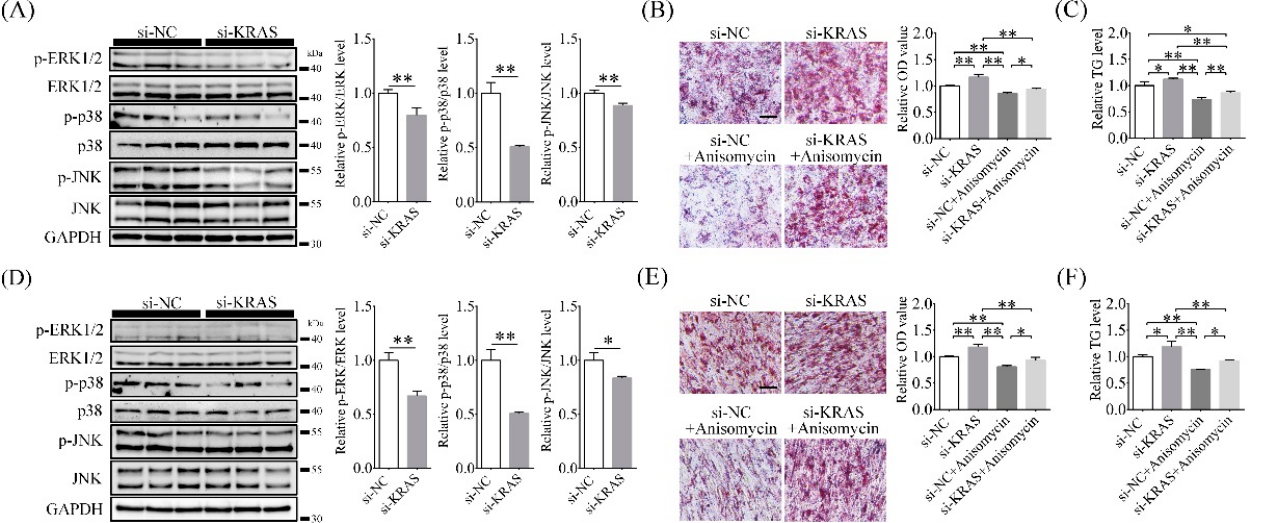
Figure 6. Effects of KRAS on mitogen-activated protein kinases (MAPK) activation in 3T3-L1 and C2C12 cells. ( A ) Changes in extracellular regulated protein kinases (ERK), c-Jun N-terminal kinase (JNK), and p38 phosphorylation levels in 3T3-L1 cells detected by Western blot analysis. Significant differences are represented with ** ( p < 0.01). ( B ) The representative ORO staining images and relative ORO OD values showed the different lipid accumulations in 3T3-L1 cells with different treatments after induction of adipogenic differentiation. Scale bar = 50 µ m. Significant differences are represented with * ( p < 0.05) and ** ( p < 0.01). ( C ) The relative TG level changes in 3T3-L1 cells with different treatments. Significant differences are represented with * ( p < 0.05) and ** ( p < 0.01). ( D ) Changes in ERK, JNK, and p38 phosphorylation levels in C2C12 cells detected by Western blot analysis. Significant differences are represented with * ( p < 0.05) and ** ( p < 0.01). ( E ) The representative ORO staining images and relative ORO OD values showed the different lipid accumulations in C2C12 cells with different treatments after induction of adipogenic differentiation. Scale bar = 50 µ m. Significant differences are represented with * ( p < 0.05) and ** ( p < 0.01). ( F ) The relative TG level changes in C2C12 cells with different treatments. Significant differences are represented with * ( p < 0.05) and ** ( p <